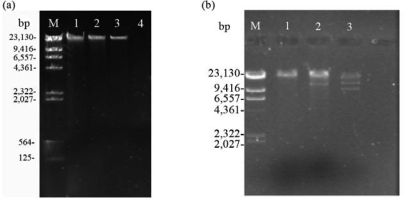
Agarose gel electrophoresis of DNA of Tb. (a) Agarose gel electrophoresis of DNA of Tb(lane 1), digested with nucleases S1 - (lane2), Rnase A - (lane 3) and Dnase I - (lane 4). Molecular size markers (kb) were HindIII-digested lambda DNA. (b) Agarose gel electrophoresis of DNA of Tb (lane 1), digested with restriction endonucleases BamHI (lane 2), EcoRI (lane 3). Molecular size markers (kb) were HindIII-digested lambda DNA.